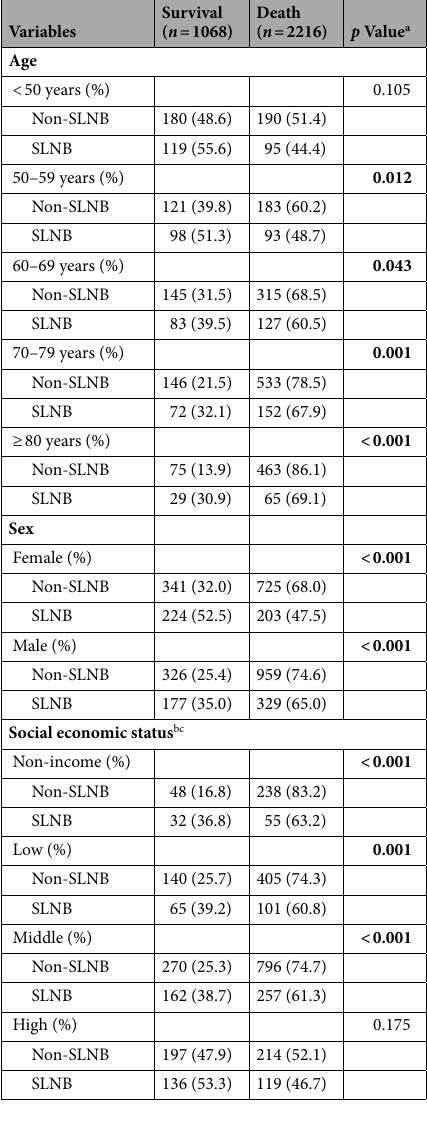
Table 4. Subgroup analysis of age, sex and social economic status for SLNB by prognosis ( n = 3284). a Using Chi-square test. Bold type indicates statistical significantly ( P < 0.05). b Social economic status was classified as non-income (no income), low (income ranges from 1 to 583 US$ per month), middle (income ranges from 584 to 833 US$ per month) and high (income ≥ 834 US$ per month) categories. c 49 patients were